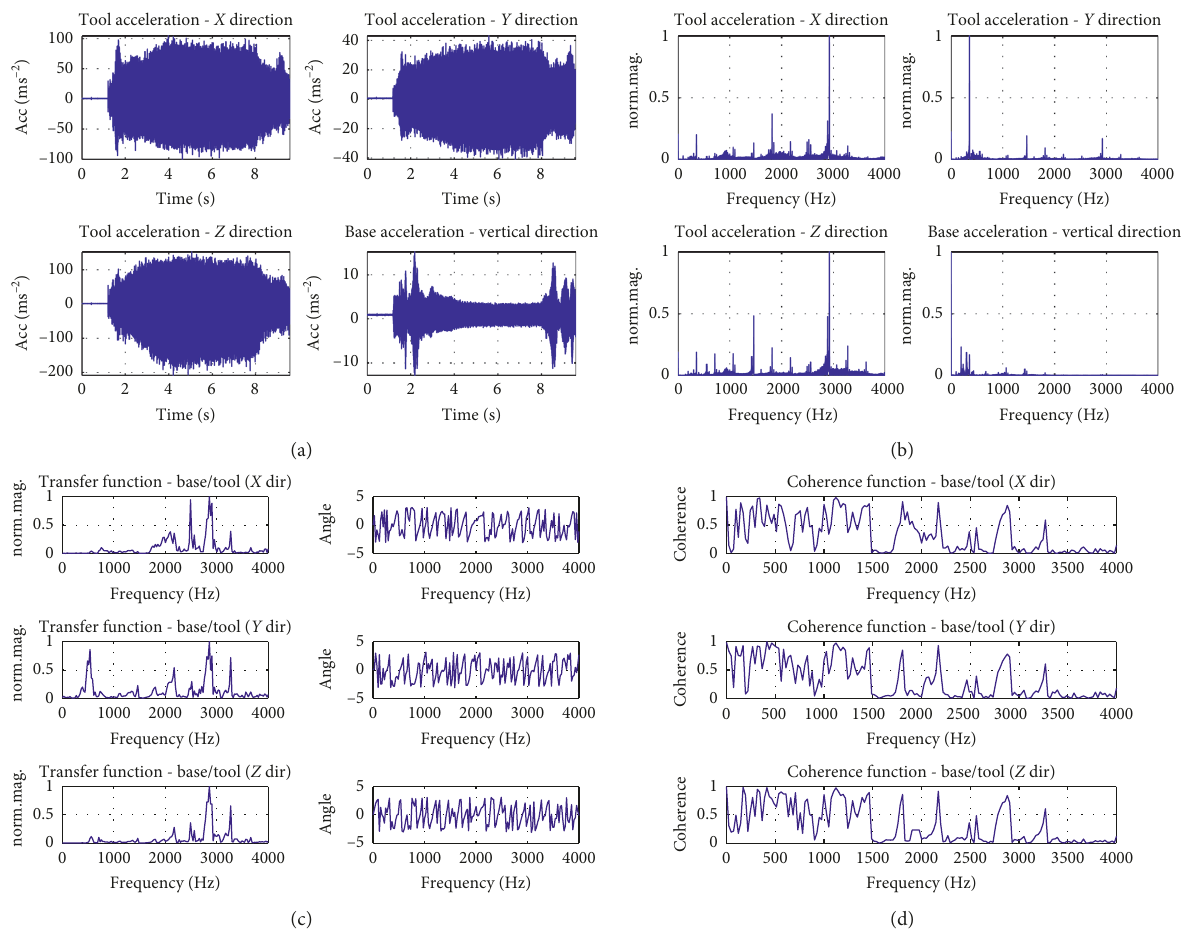
Figure 6: Timed evolution of accelerations (a), with normalized magnitudes of their spectrum (b), transfer functions (c), and coherences (d) between the bed frame and milling head, for the third